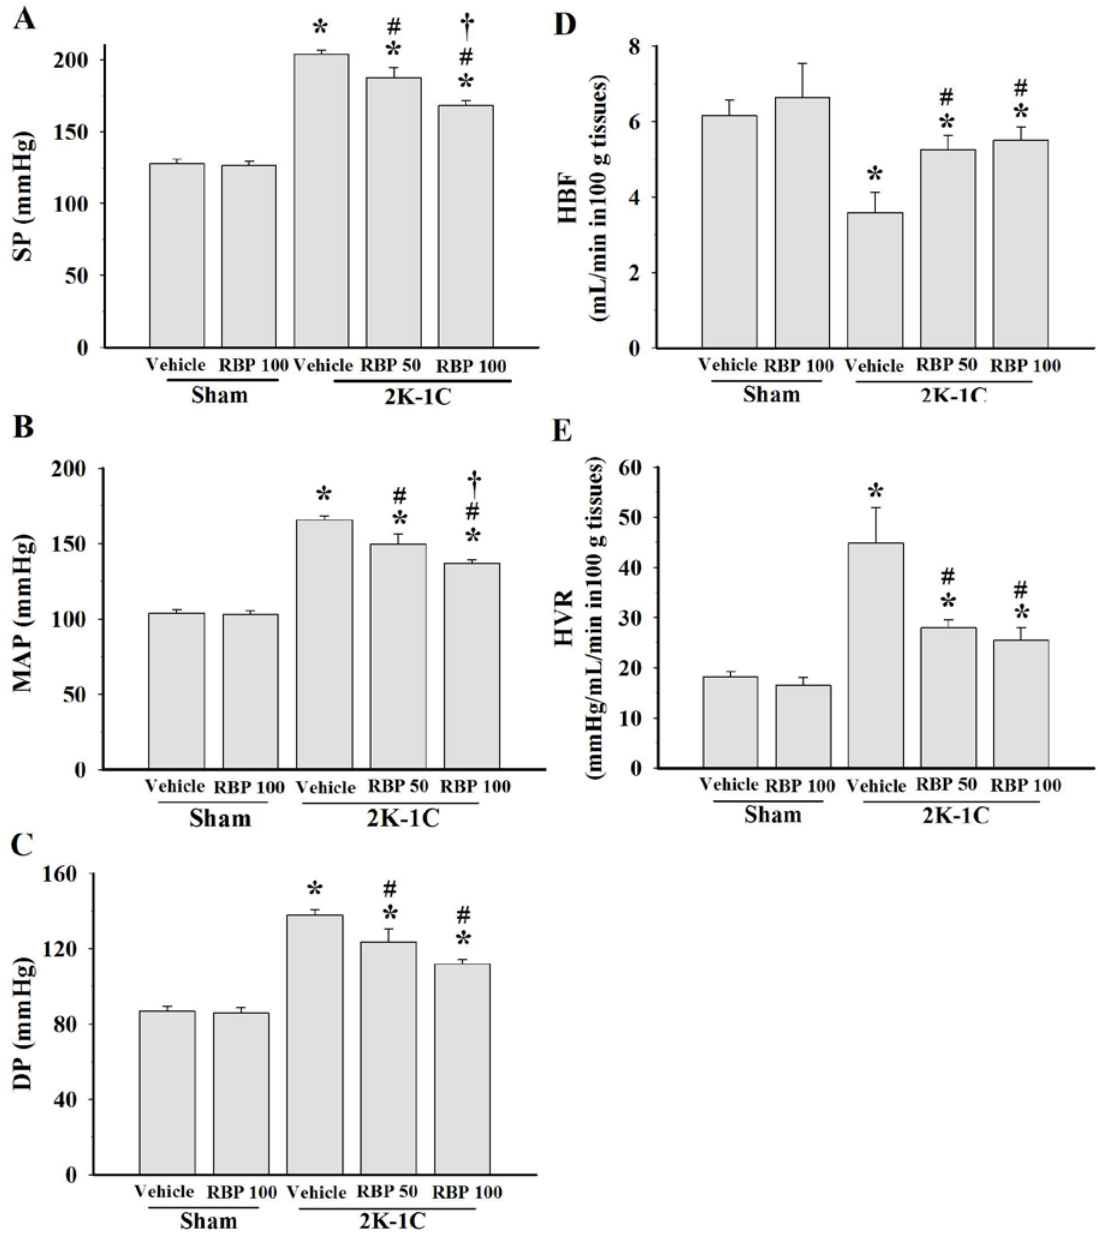
Figure 3. Effect of RBP on systolic blood pressure ( A ); mean arterial pressure ( B ); diastolic blood pressure ( C ); hindlimb blood flow ( D ) and hindlimb vascular resistance ( E ). Data are mean values ± SEM; ( n = 8/group), * p < 0.05 vs. sham-operated group, # p < 0.05 vs. 2K-1C group and † p < 0.05 vs. 2K-1C + RBP50 group; Rice bran peptides, RBP.